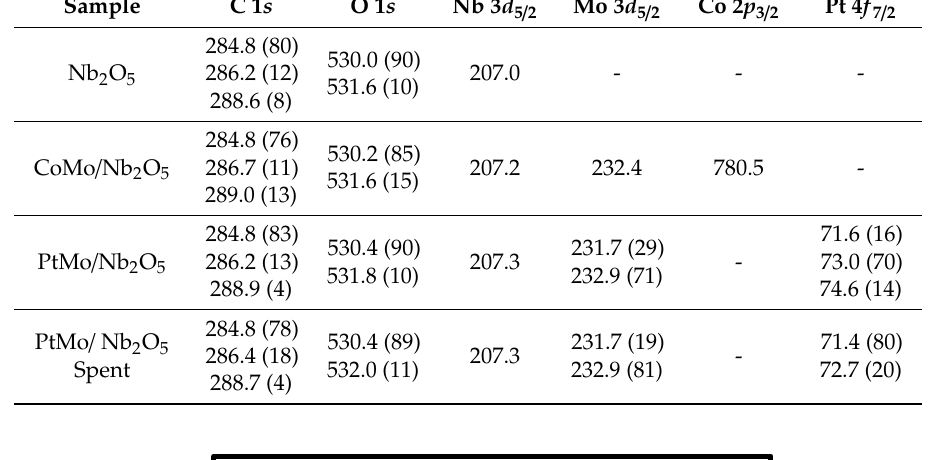
Table 2. Binding energies (in eV) of the constituent elements for the studied catalysts. The values in parentheses are the area% of each contribution.